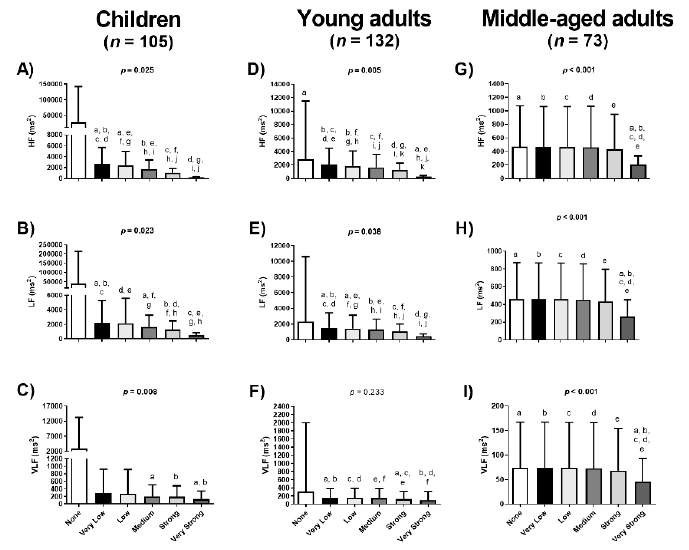
Figure 3. Di ff erences on the Heart Rate Variability (HRV) frequency-domain parameters using di ff erent Kubios filter in three di ff erent cohorts. Data are represented as mean and standard deviation. HF: power in the high frequency (in absolute units, ms 2 ; Panels A, E and I ); LF: power in the low frequency (in absolute units, ms 2 ; Panels B, F and J ); LF / HF: ratio of the power in the low frequency divided by the power in the high frequency (Panels C, G and K ); VLF: power in the very low frequency (in absolute units, ms 2 ; Panels D, H and L ). p value from the ANOVA comparisons; similar letters means Bonferroni post ‐ hoc differences.